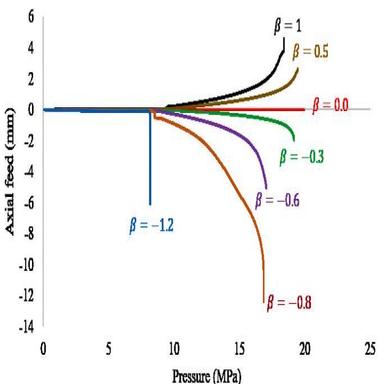
Boundary conditions generated by the FEM + PID method for the seven different strain paths (a negative axial feed value means a compressive axial feed).